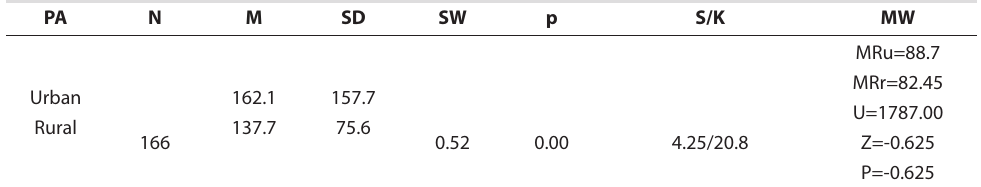
TABLE 4 Urban and rural children’s PA descriptive